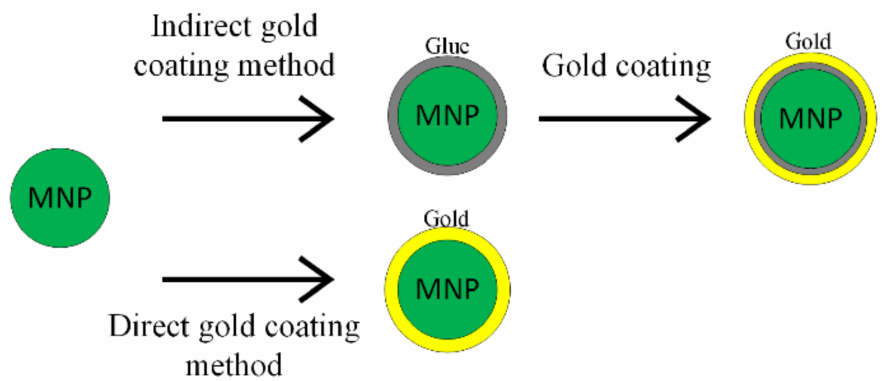
Figure 3. Gold coating methods’ schematic representation.